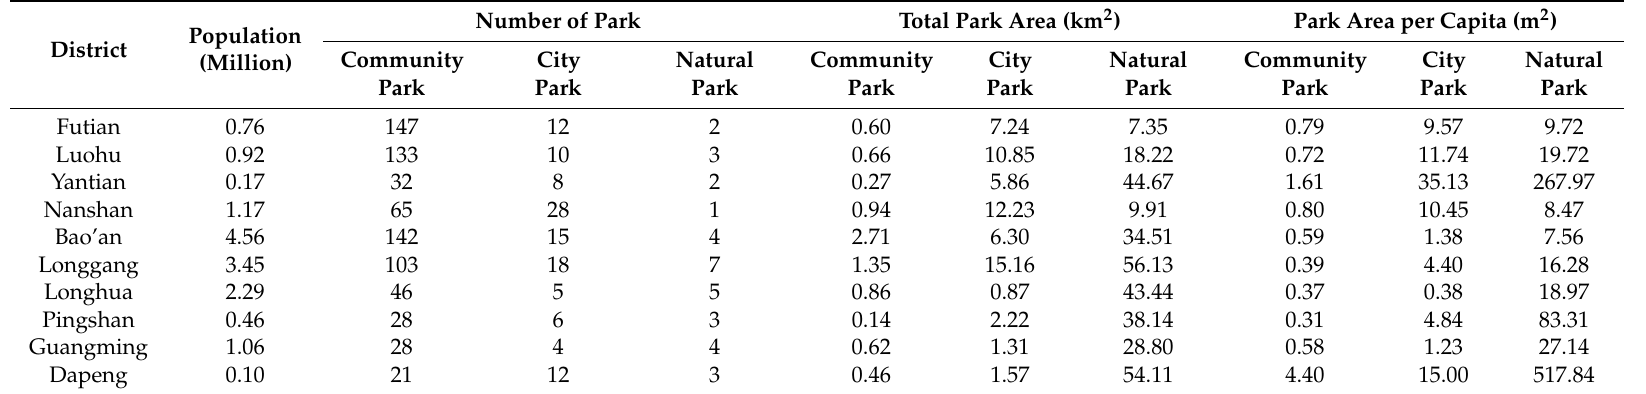
Table 1. Descriptive statistics of parks in Shenzhen’s